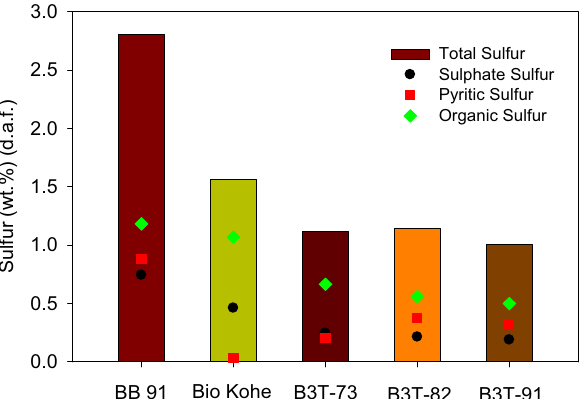
Fig. 3 The amount of sulfur content of bio-coal briquettes treated by Garant (cid:3)